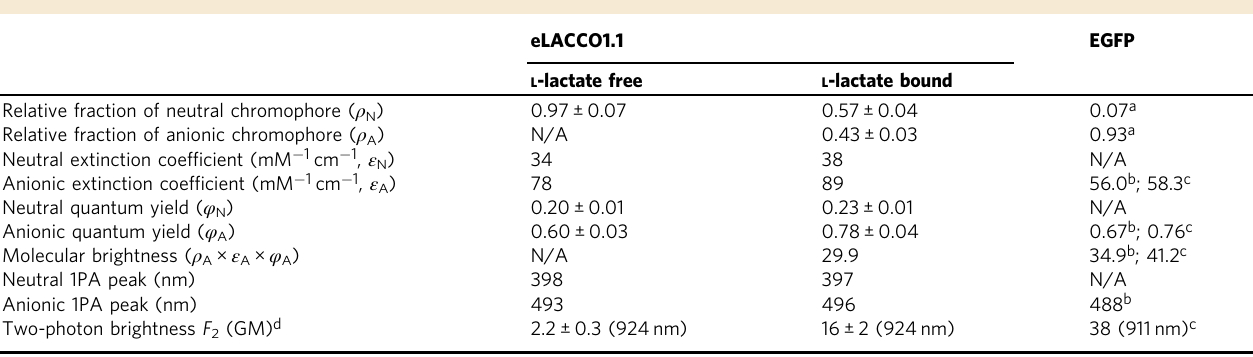
Mean±s.d. N/A, not applicable. Subscript A and N correspond to the anionic and neutral form of chromophore, respectively. a Calculated using the equation, log 10 ([anionic]/[neutral]) = pH − p K a , where pH is 7.2 and p K a is 6.1 (ref. 16 ). b Data from ref. 16 . c Data from ref. 17 . d Two-photon brightness is calculated as F 2 = ρ A × σ 2,A × φ A at the peak wavelength (in parentheses), where σ 2,A is the peak two-photon absorption cross